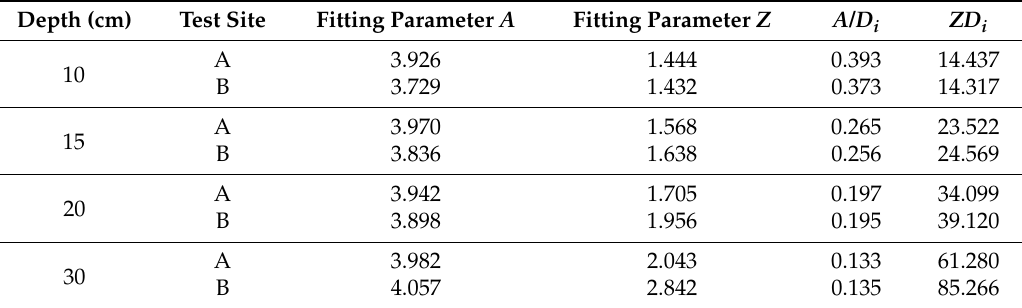
Table 1. Values of fitting parameters A and Z